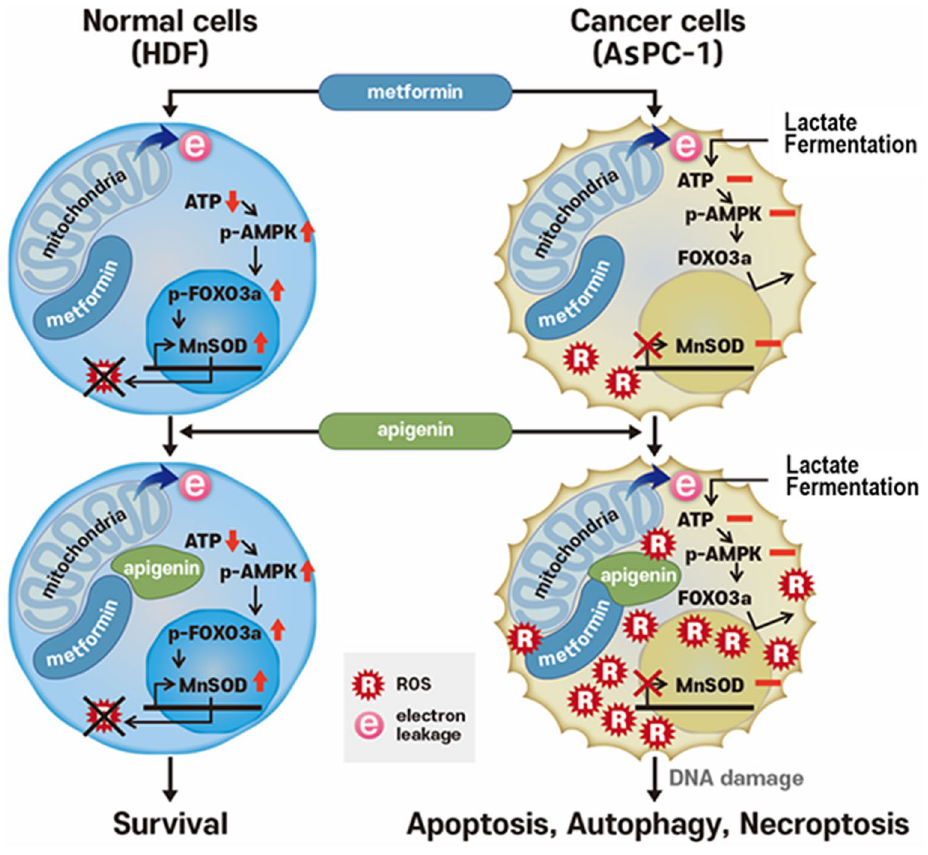
Figure 8. Hypothetical diagram depicting mechanism of differential cell death induced by combination of metformin and apigenin between HDF and AsPC-1